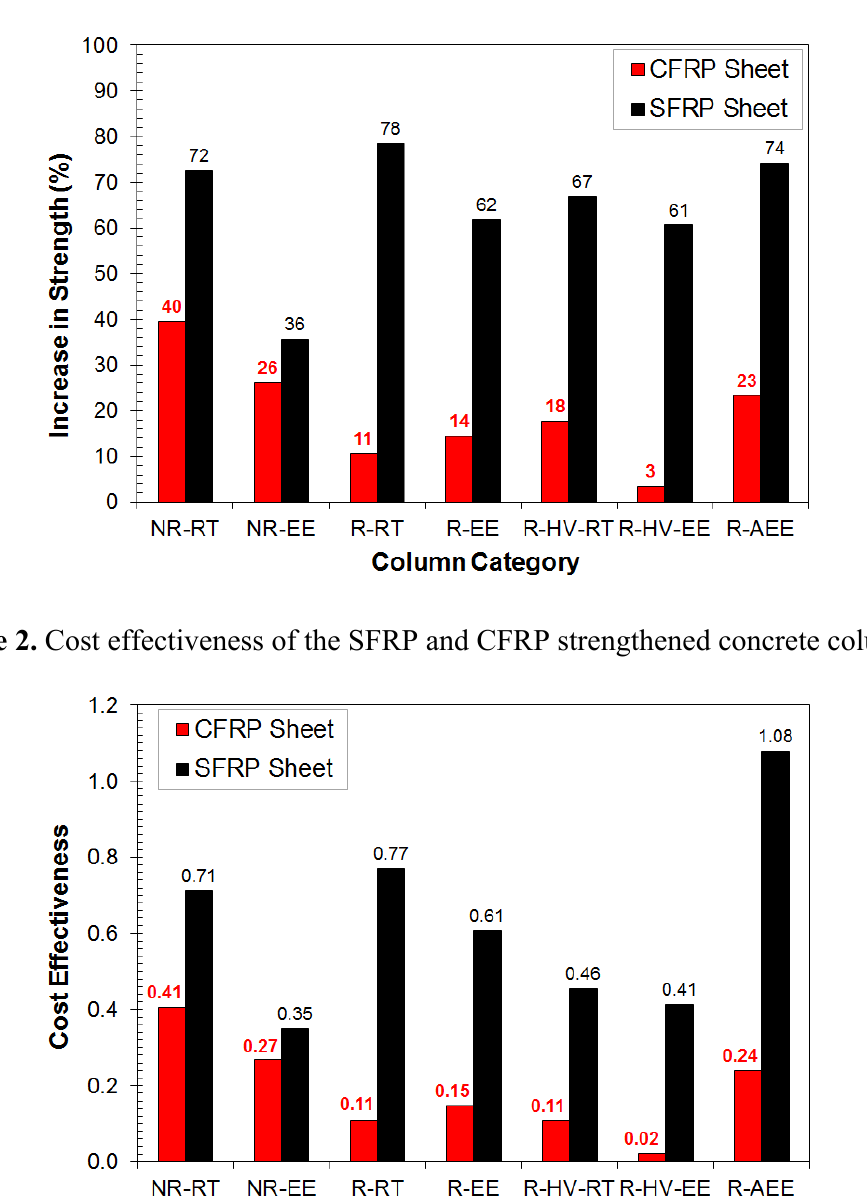
Figure 1. Percentage increase in the strength of the SFRP and CFRP strengthened concrete columns.